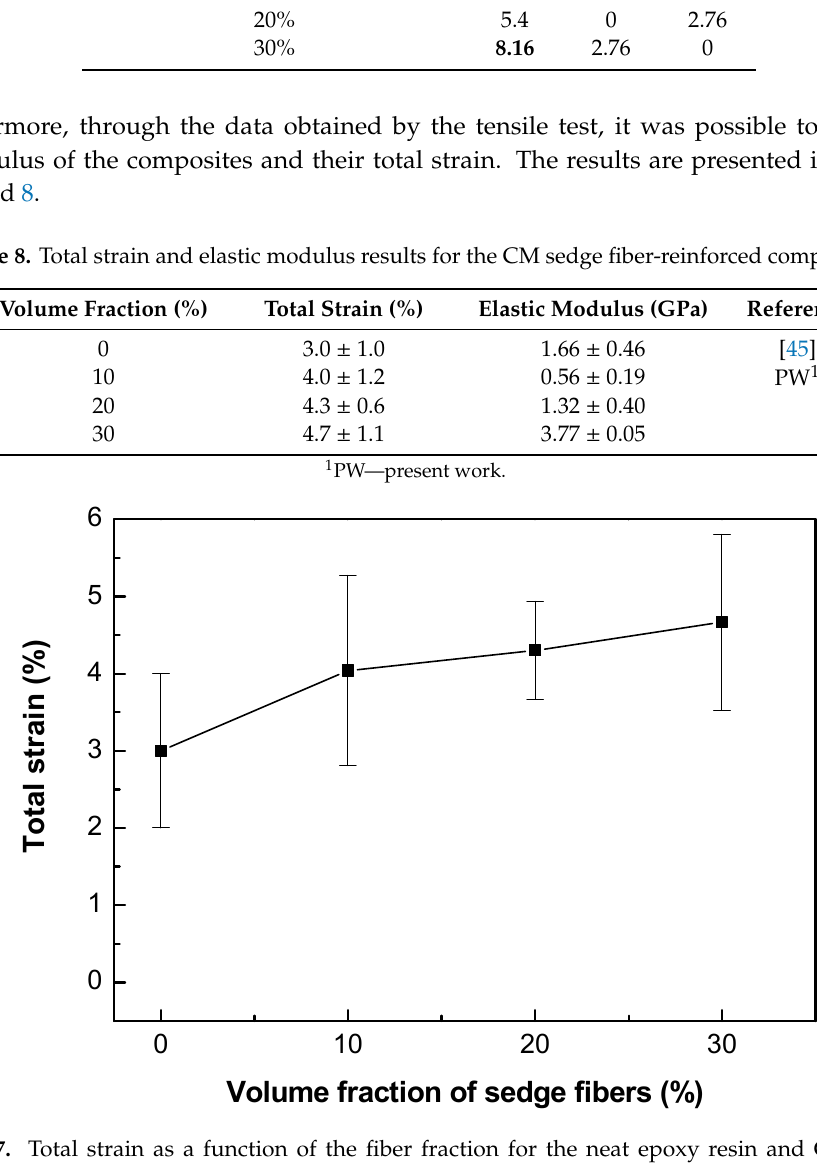
Figure 8. Elastic modulus as a function of the fiber fraction for the neat epoxy resin and CM sedge fiber-reinforced composites. According to Table 8 and Figure 8, it is possible to observe a clear tendency of increasing the elastic modulus of the composites as the volumetric fraction of fibers increases, probably because of the higher stiffness of the fibers. Comparing to literature data for the same epoxy resin [58], only the 30 vol.% CM fiber-reinforced composite showed higher modulus, probably due to difficulties in load transfer in the fiber-matrix interface. On the other hand, the total strain graph, Figure 7, did not show any significant variation between the different materials, within the standard deviation. Preliminary tensile results for the CM sedge fiber indicated a maximum strength of 164 MPa, an elastic modulus of 4.4 GPa, and a total strain of 4.1%. In particular, the CM sedge fiber maximum